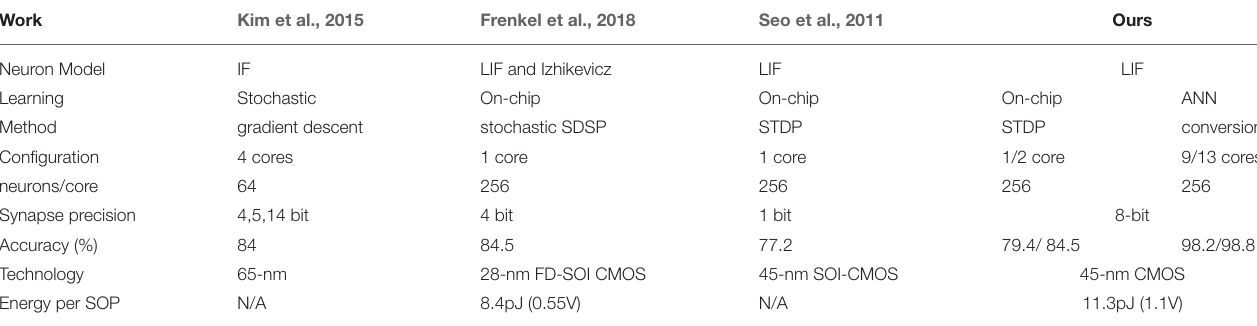
TABLE 4 | Comparison result of MNIST accuracy on hardware neuromorphic